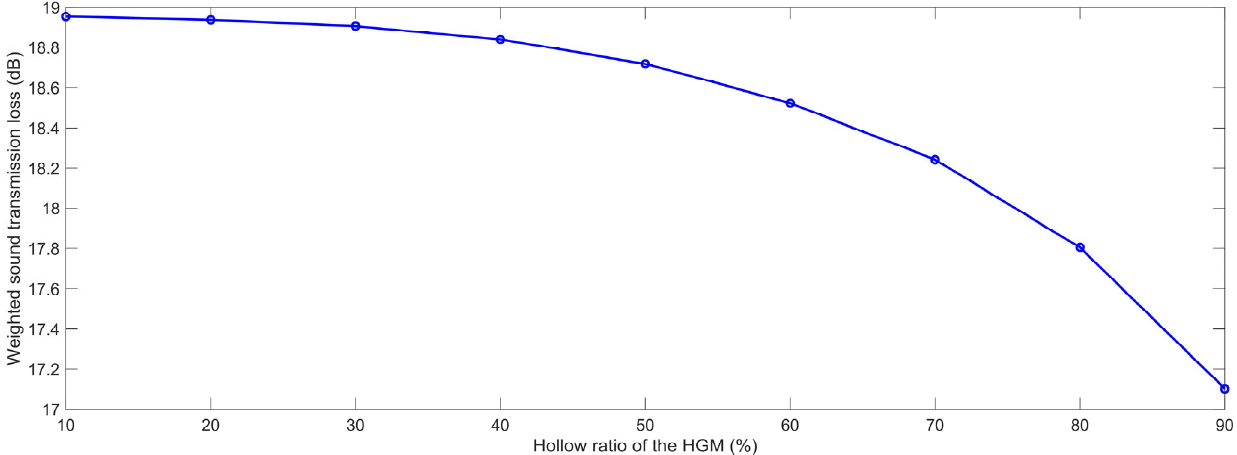
Figure 11. The weighted STL of the composite rubber reinforced with HGM for the various hollow ratio of the